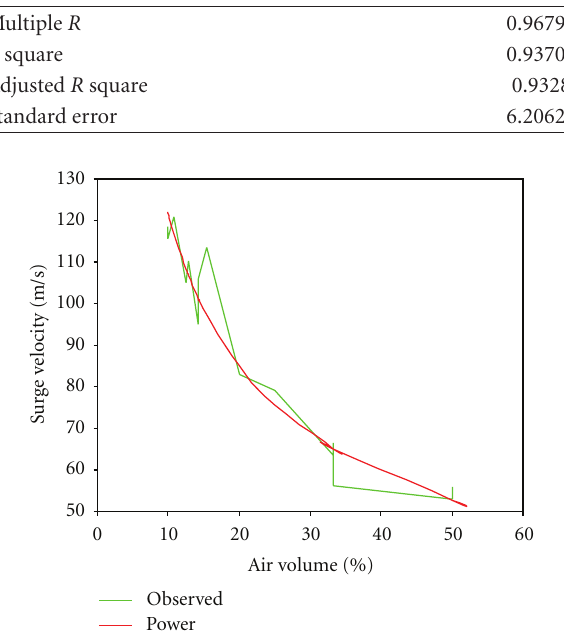
Table 2: List-wise deletion of missing data for curve fit by logarithmic method.